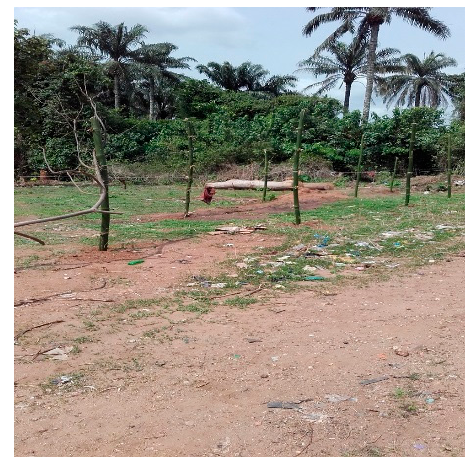
Figure 5. A bamboo and knotted fabric line perimeter fence.